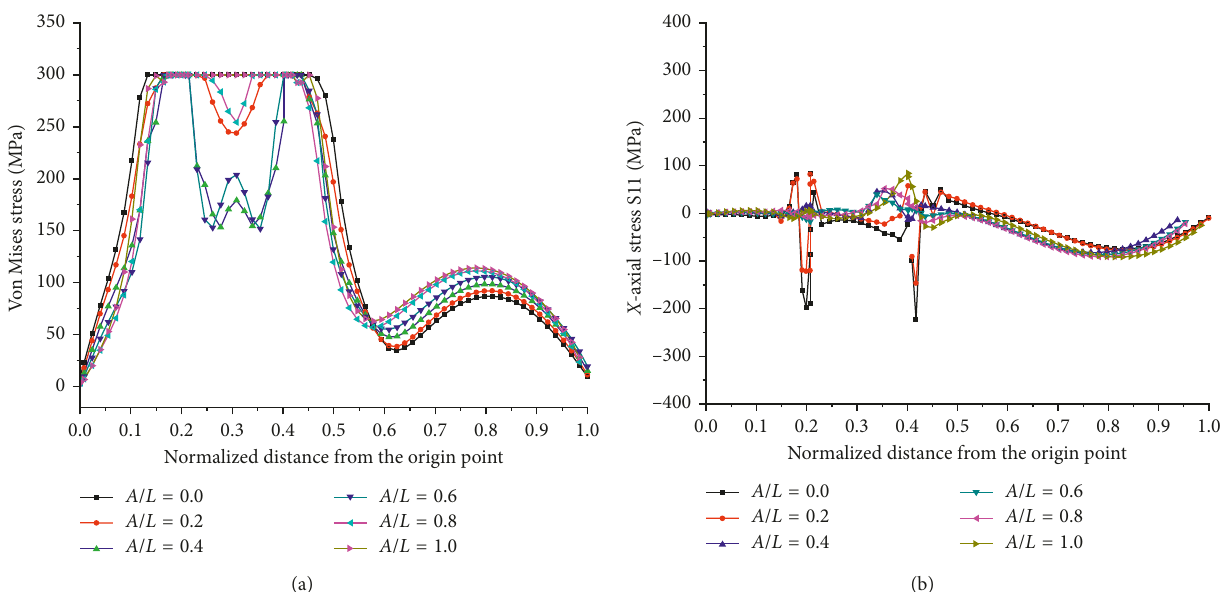
Figure 14: Mises stress and S11 stress distribution curves of the joint slot. (a) Equivalent stress distribution curve. (b) X-axial stress distribution curve.